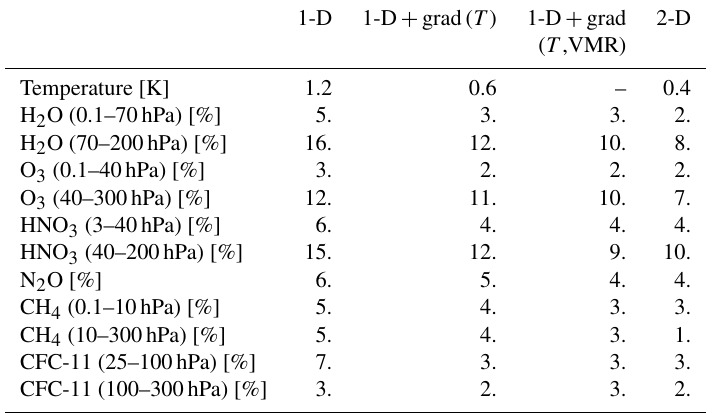
Figure 6. RMSE calculations for O 3 (upper panels) and HNO 3 (lower panels) in polar winter, polar summer, midlatitude, equatorial and whole orbit scenarios. The colour code is the same as in Fig. 5. Table 1. Errors due to different treatments of horizontal inhomogeneities (1-D, 1-D + grad( T ), 1-D + grad( T ,VMR), 2-D) for each